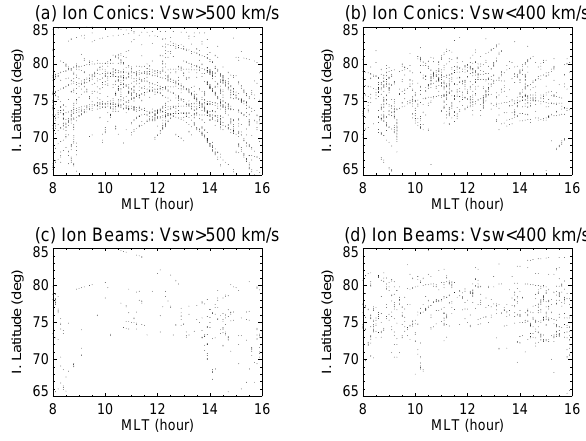
Fig. 5. Location of ion conics event in MLT-I.Lat coordinate when solar wind velocity is (a) large and (b) small, and that of the ion beam event when the solar wind velocity is (c) large and (d) small. all the local times including the local